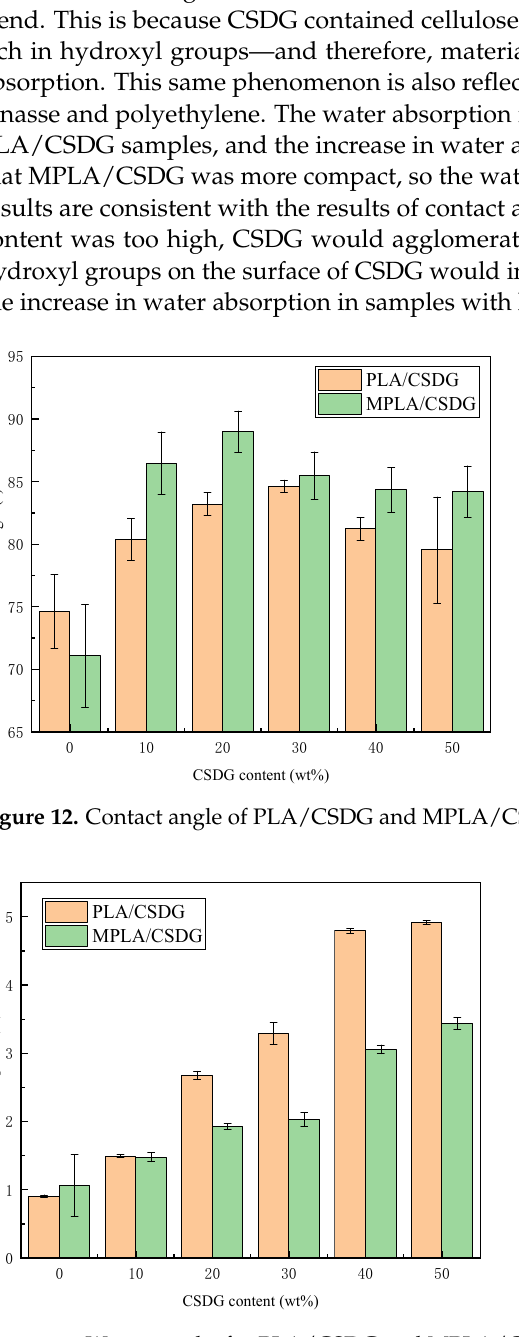
Figure 11. Schematic of molecular permeation path for water vapor or oxygen: ( a ) PLA/CSDG; ( b ) MPLA/CSDG.